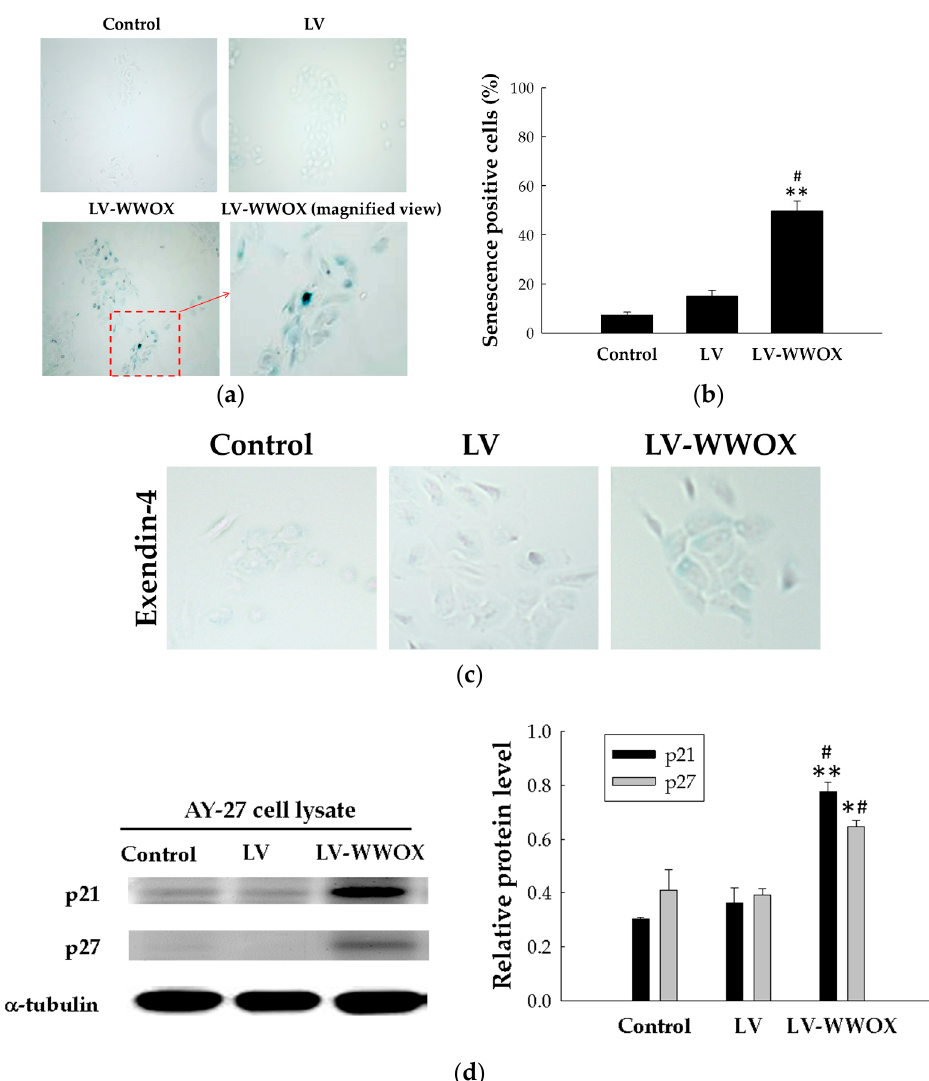
Figure 4. WWOX induced premature senescence in AY-27 cells. ( a ) SA- β -gal staining increased with LV-WWOX treatment in the AY-27 cells. ( b ) The percentage of SA- β -gal-positive senescent cells in the LV-WWOX-treated, LV, and control AY-27 cells is presented as the mean ± SD. ** p < 0.01 compared to the control groups; # p < 0.05 compared to the LV groups. ( c ) SA- β -gal staining of exendin-4-treated AY-27 (control), AY-27-LV, and AY-27-LV-WWOX cells. ( d ) The expression of p21 and p27 in the LV-WWOX-treated, LV, and control AY-27 cells was detected by Western blot. α -Tubulin served as a loading control. Each bar represents the mean ± standard deviation (SD) from three independent experiments. The results are expressed as the mean ± SD. * p < 0.05 and ** p < 0.01 compared to the control groups; # p < 0.05 compared to the LV groups.